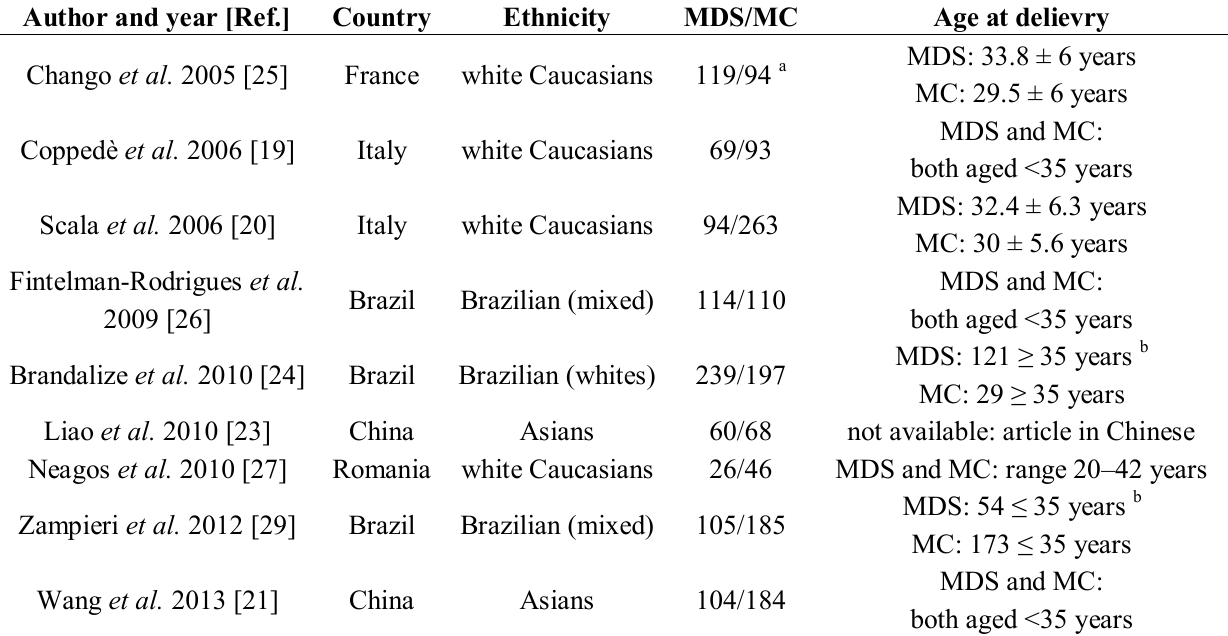
Table 1. Characteristics of the studies included in the